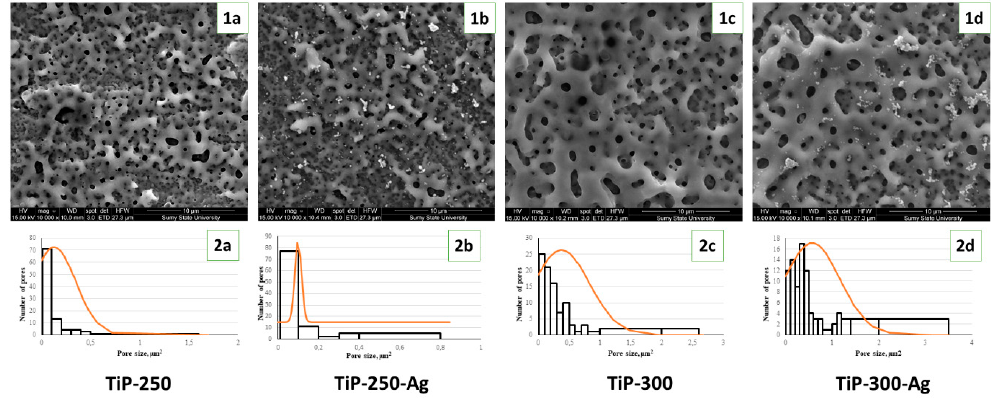
Figure 2. Scanning electron microscopy images ( 1a – d ) and pore size distribution (2 a – b ) after plasma